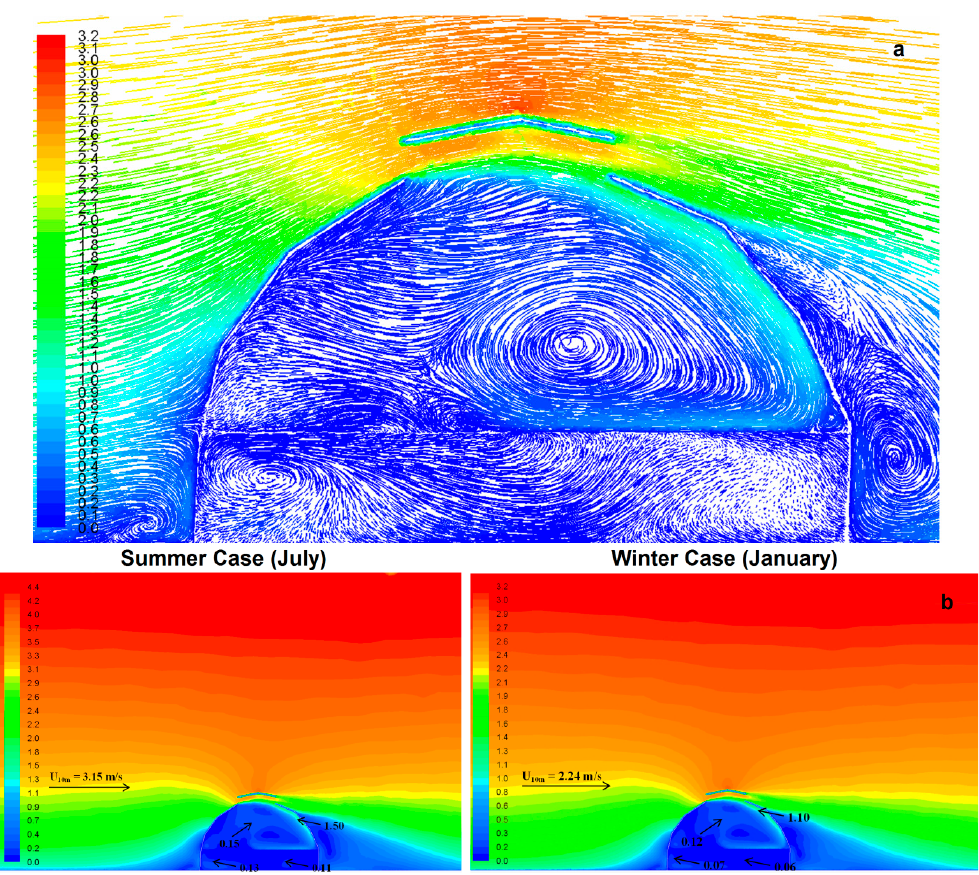
Figure 10. ( a ) Streamline plot of velocity inside the dome during summer with wind-induced flow. ( b ) Velocity contour results of the airflow distribution inside the dome (wind-induced flows).